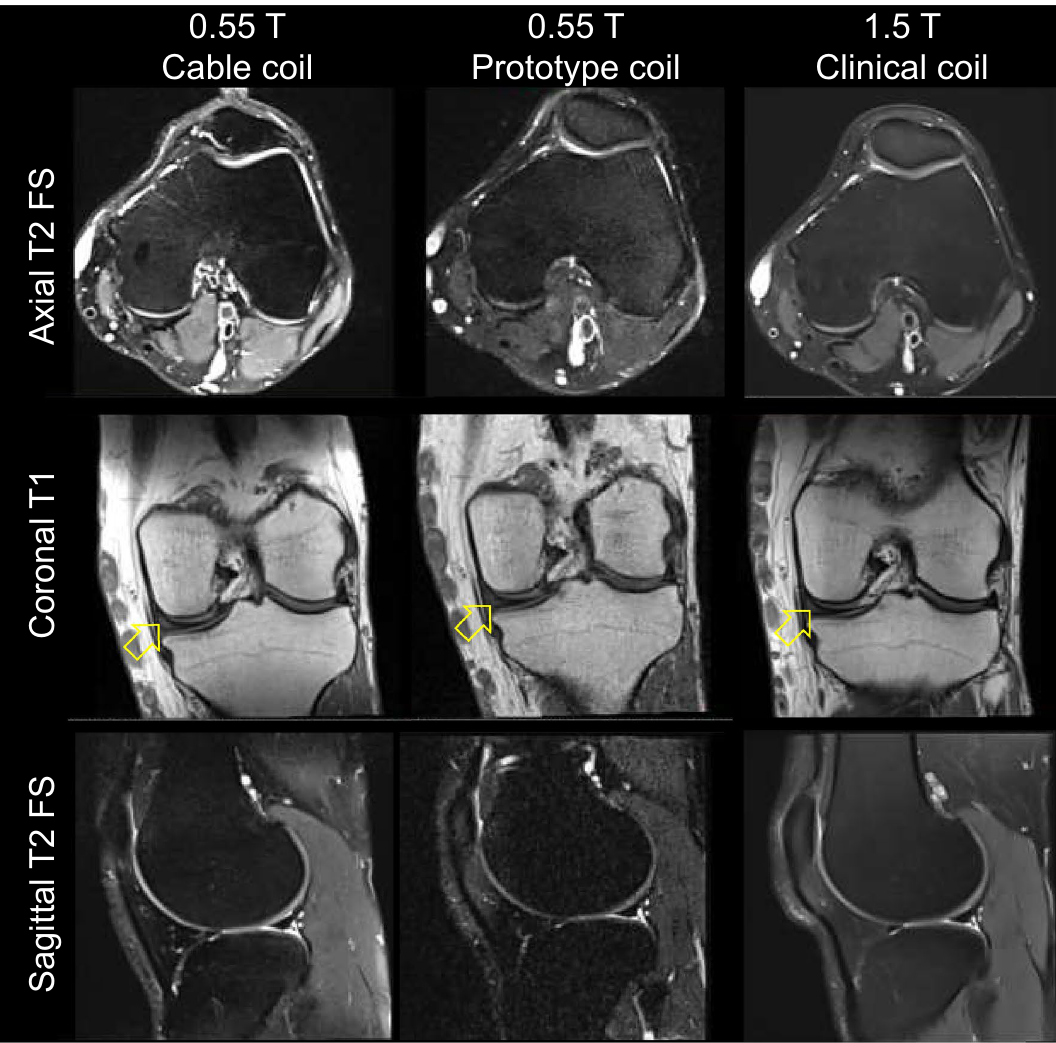
Figure 13. Representative turbo spin echo MR images of a 35-year-old man acquired using the 0.55 T 6-channel cable coil (left column), 0.55 T prototype coil (middle column) and 1.5 T clinical coil (right column). Mucinous degeneration with no meniscal tear is observed in the coronal images